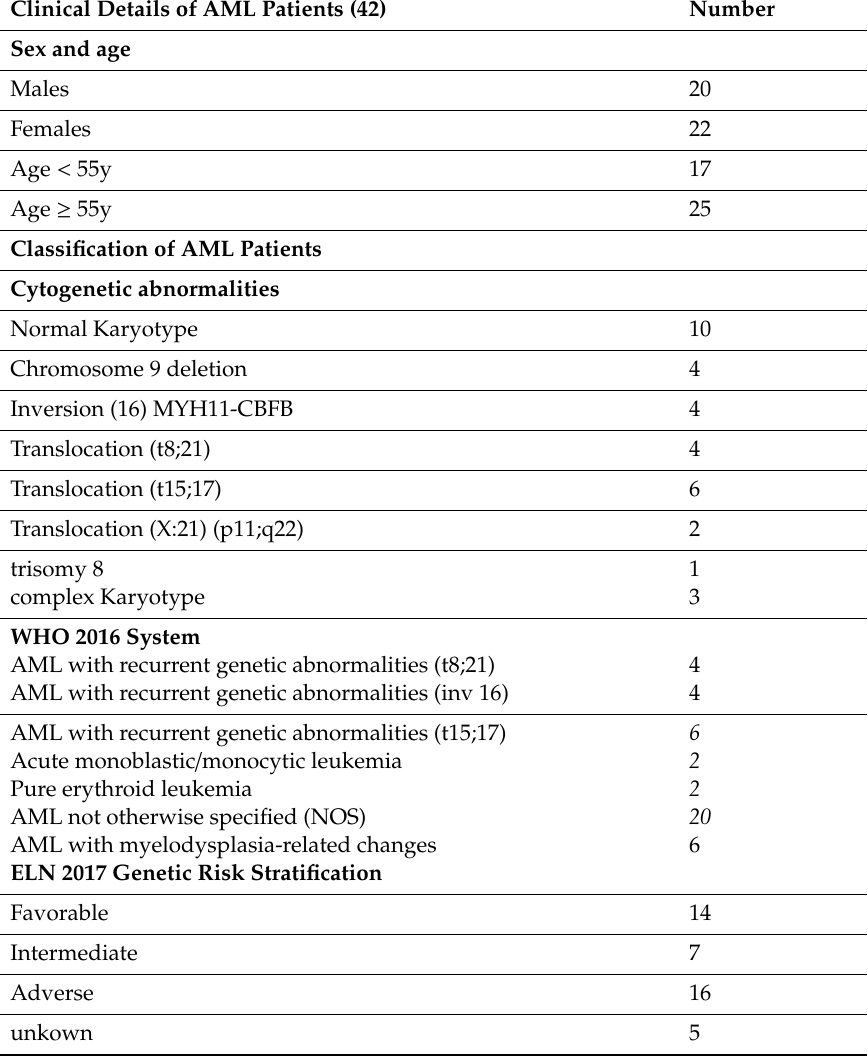
Table 6. Summary of AML patient clinical details used for the